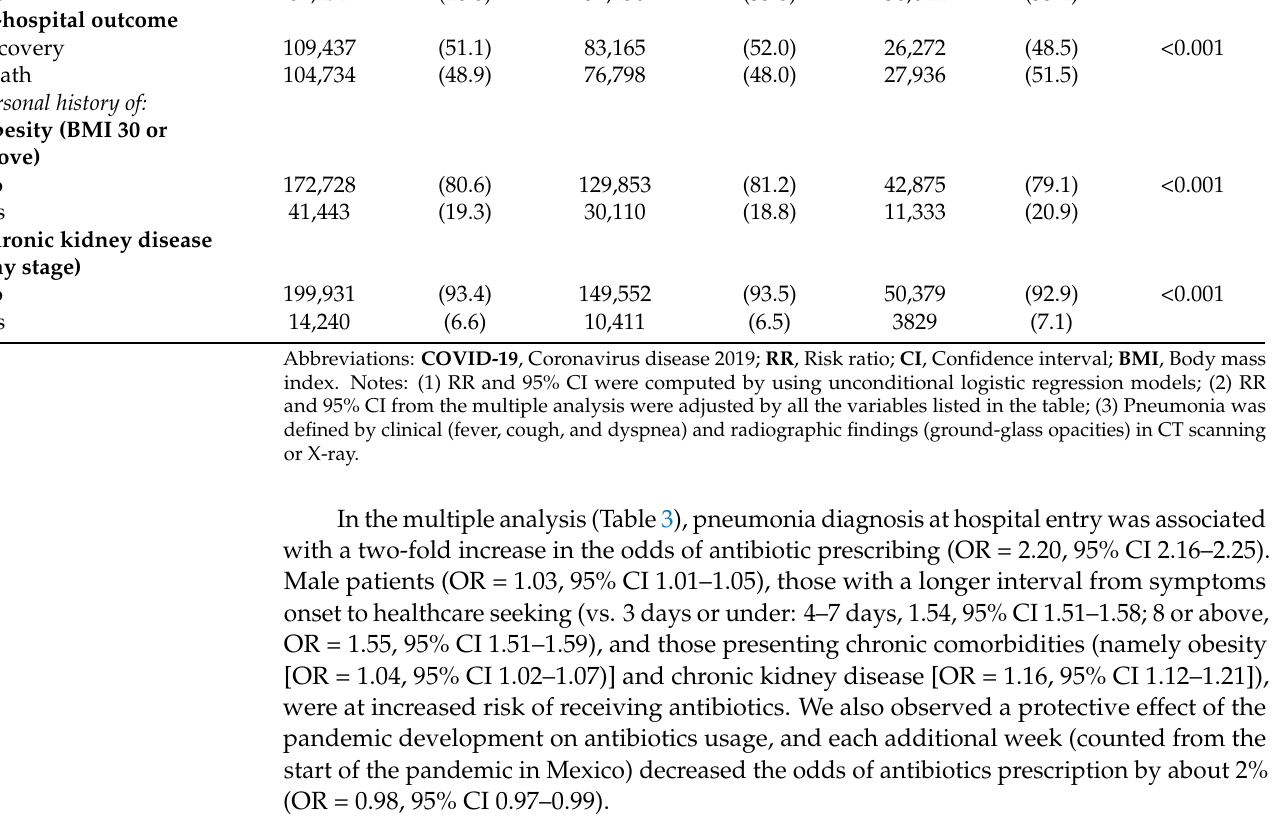
Table 2. Factors associated with the odds of antibiotic prescription at hospital admission due